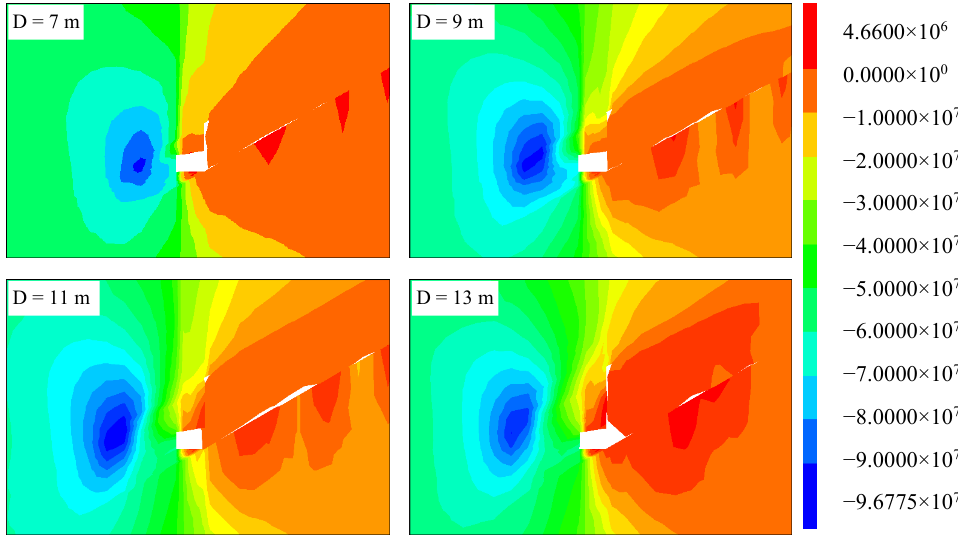
Figure 9. Vertical stress cloud diagram of surrounding rock of entry.